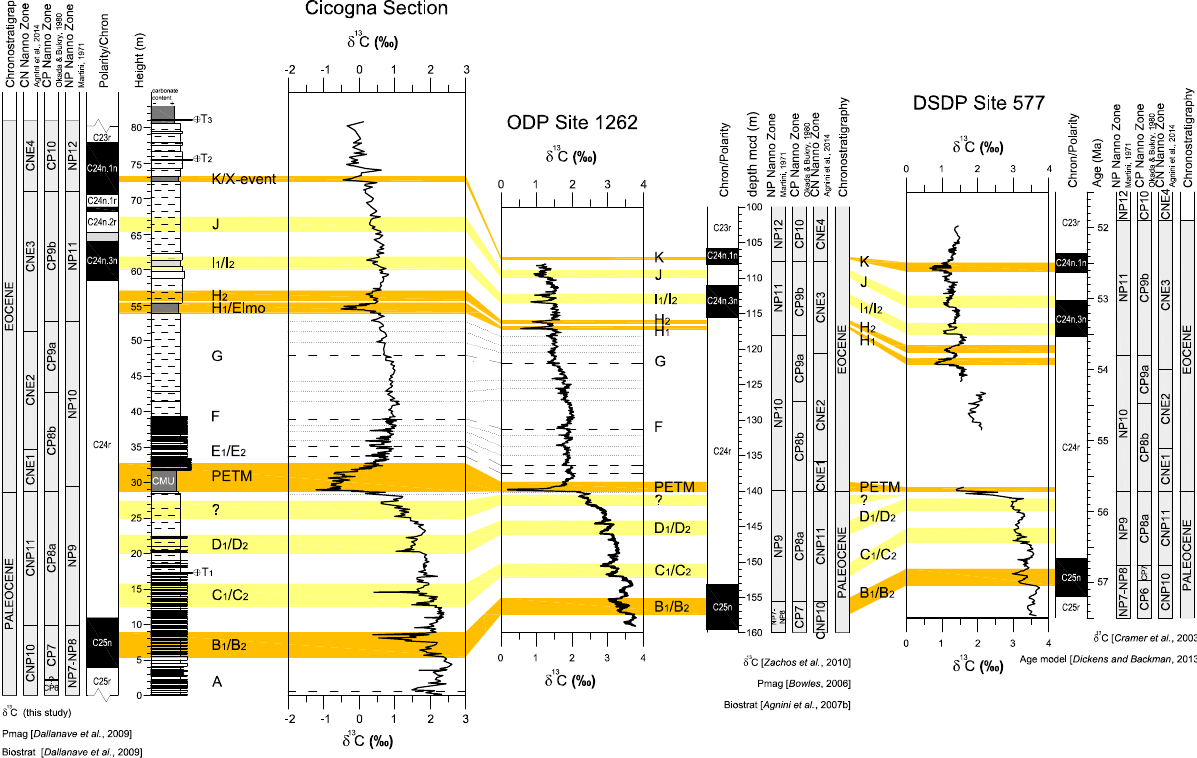
Figure 5. Stratigraphic correlation between upper Paleocene and lower Eocene sections at Cicogna, ODP Site 1262 (Zachos et al., 2010), and DSDP Site 577 (Cramer et al., 2003; Dickens and Backman, 2013). All three sites have independently derived nannofossil biohorizons, polarity chrons and δ 13 C records, which account for subtle temporal offsets. Color bands and symbols are the same as in Fig. 4. Note the missing record at Site 577 that corresponds to known core